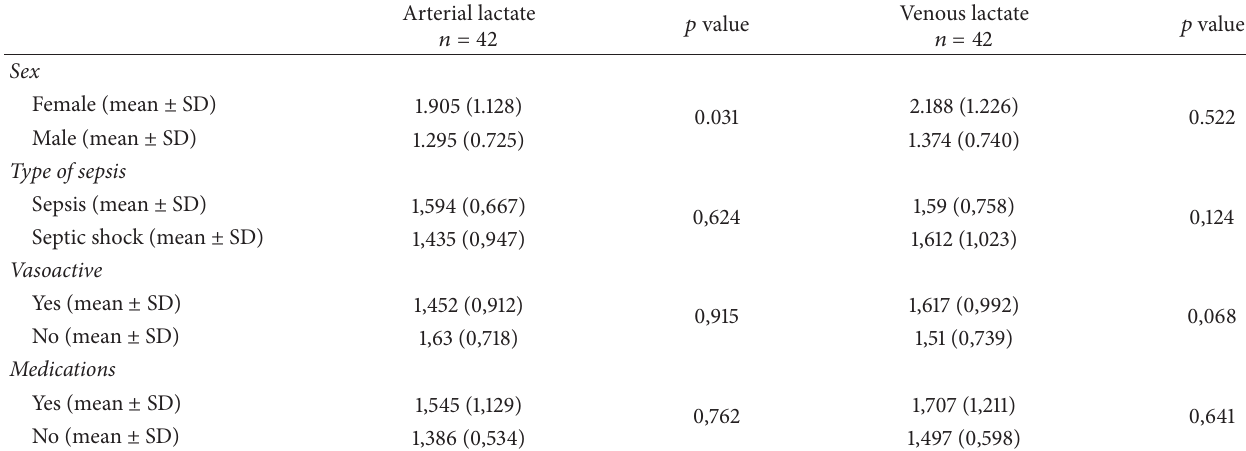
Table 3: Bivariate analysis arterial lactate versus venous lactate. Relationship between arterial and venous lactate and factors like sex, vasopressors, severity of illness, and other medications such as antibiotics and sedatives.